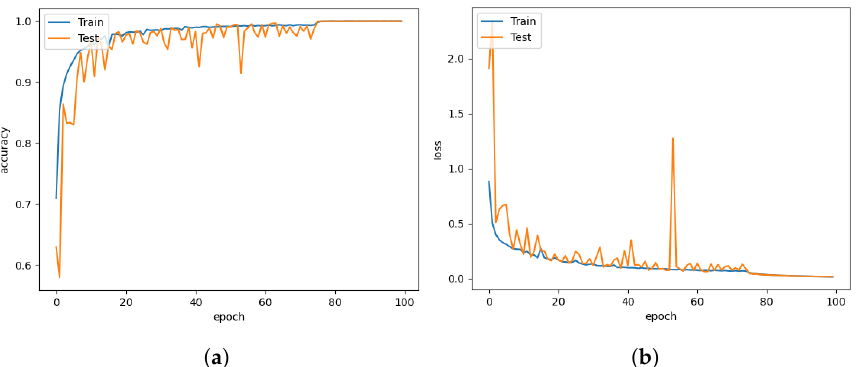
Figure 15. CNN-Inception for learning rate = 0.001. ( a ) Model accuracy. ( b ) Model